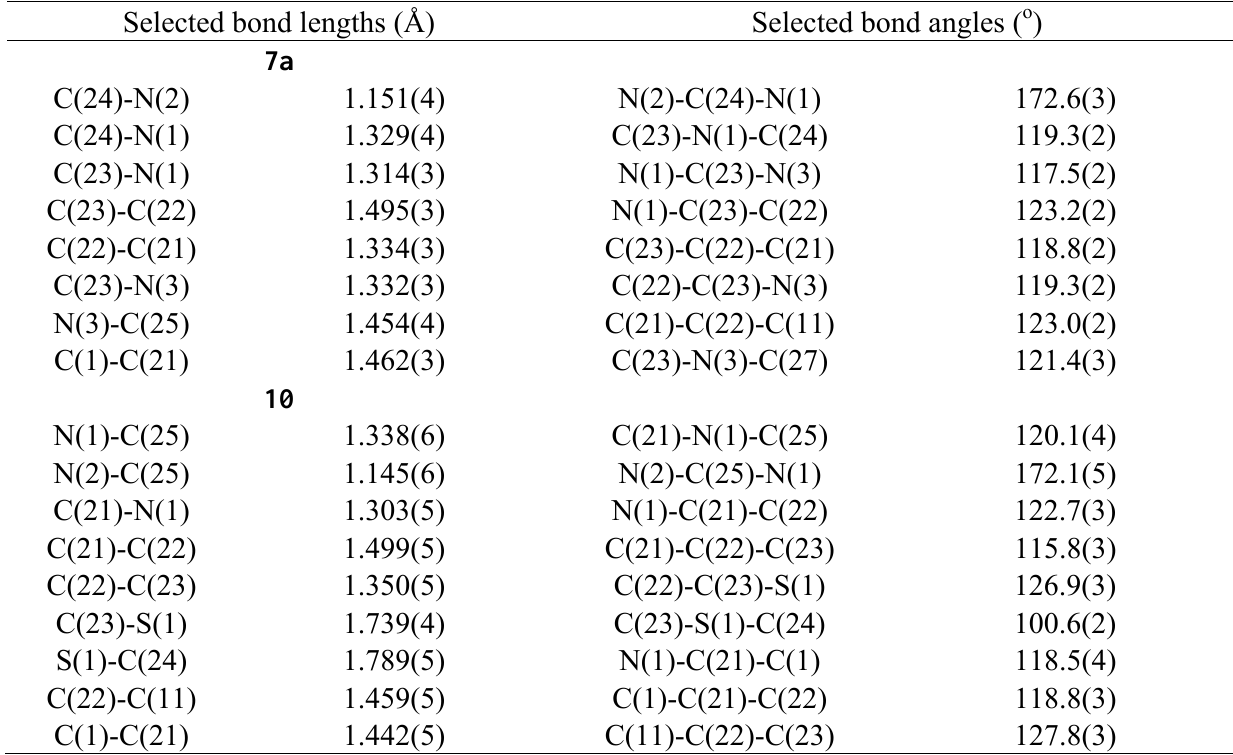
Table 1. Selected bond lengths and bond angles for compounds 7a and 10